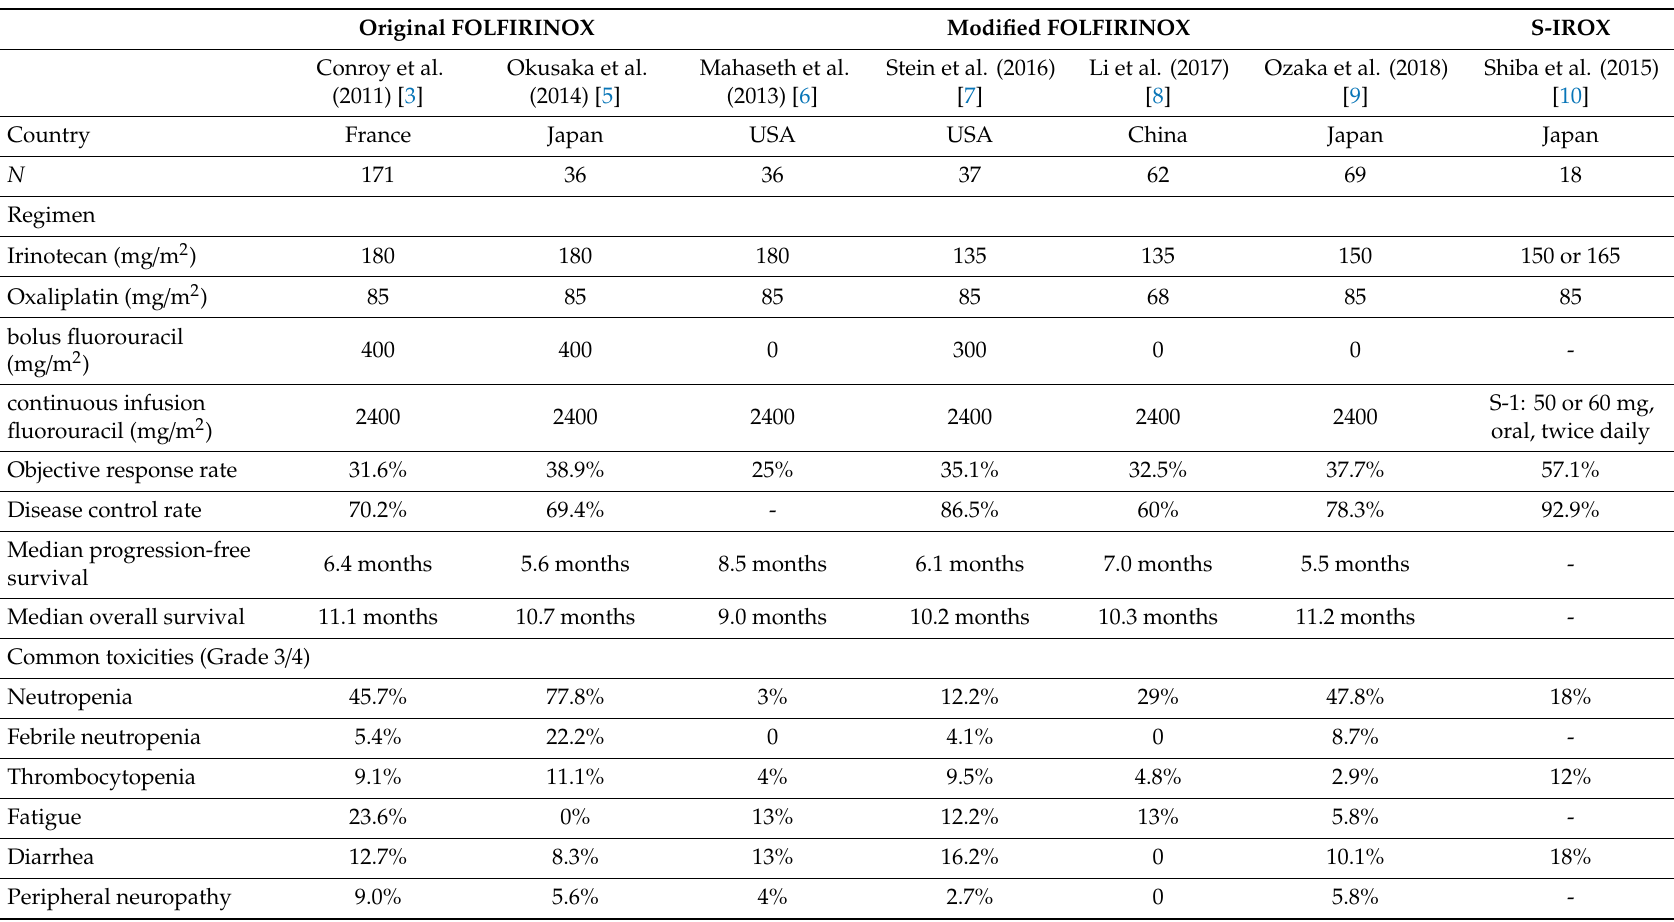
Table 1. E ffi cacy and safety of original FOLFIRINOX or modified FOLFIRINOX regimens for metastatic pancreatic